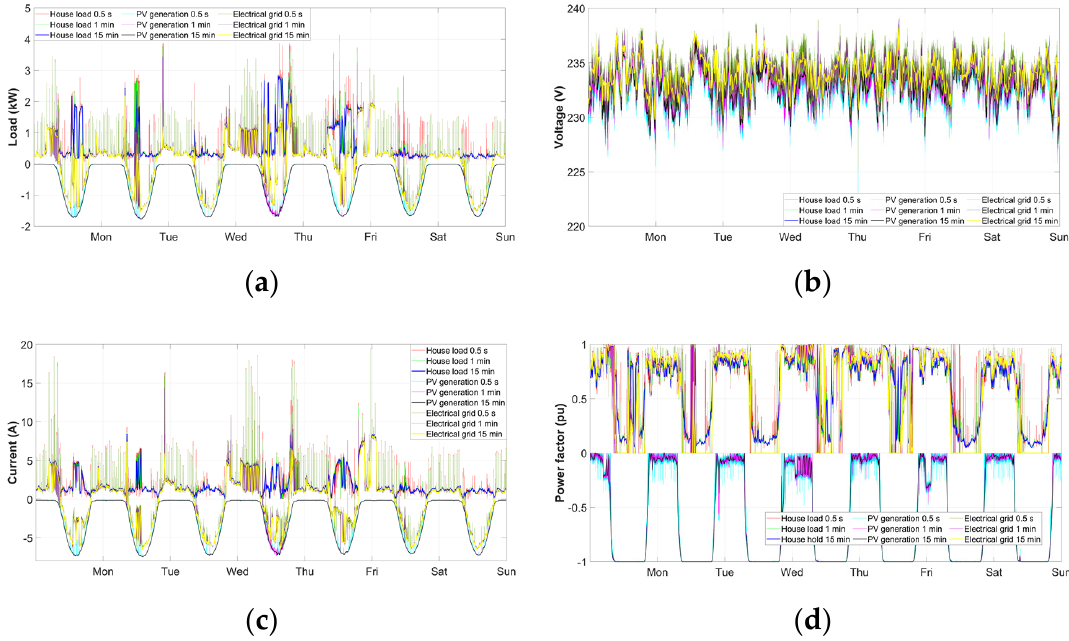
Figure 14. Weekly electrical data for Household #6: ( a ) power, ( b ) voltage, ( c ) current and ( d ) power factor.